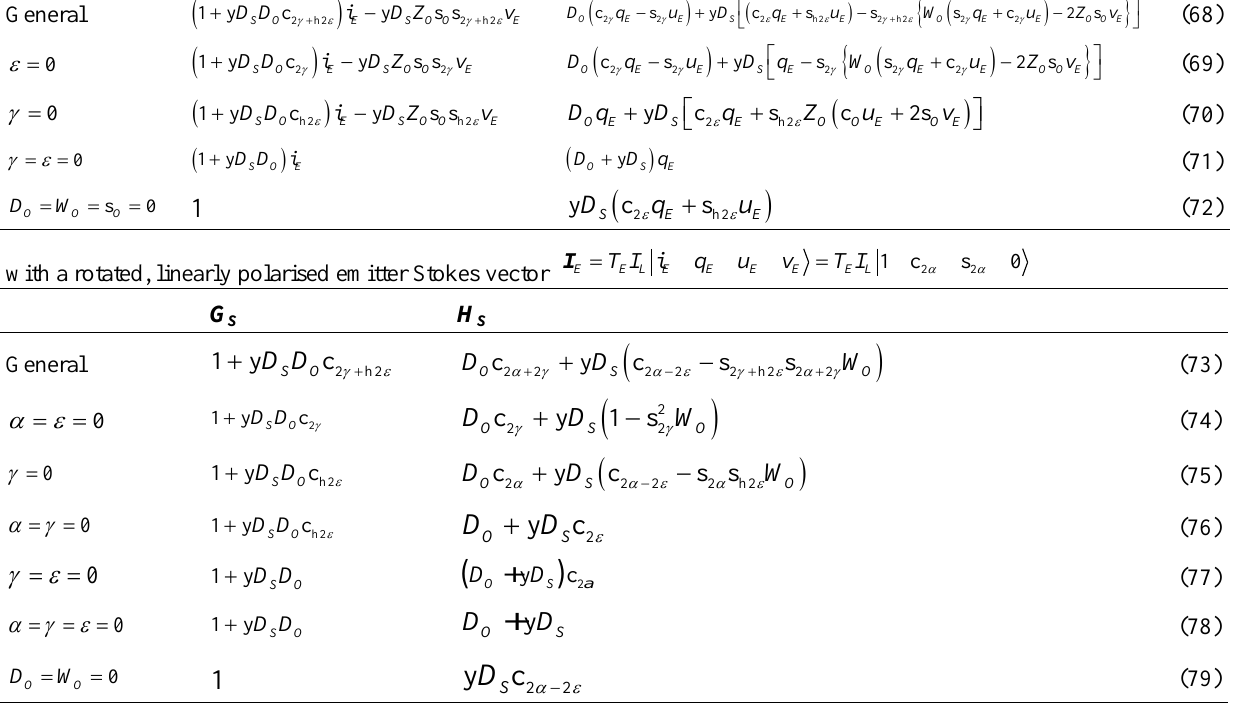
Table 1. Parameters G rotational error ε before the polarising beam-splitter, – with a general emitter Stokes vector